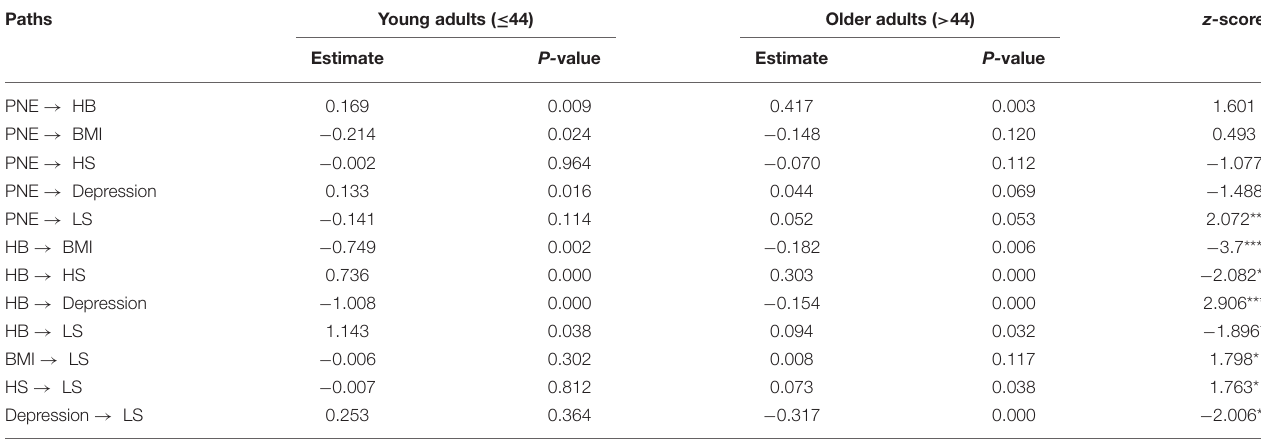
TABLE 5 | Results for moderating effects of age. Paths